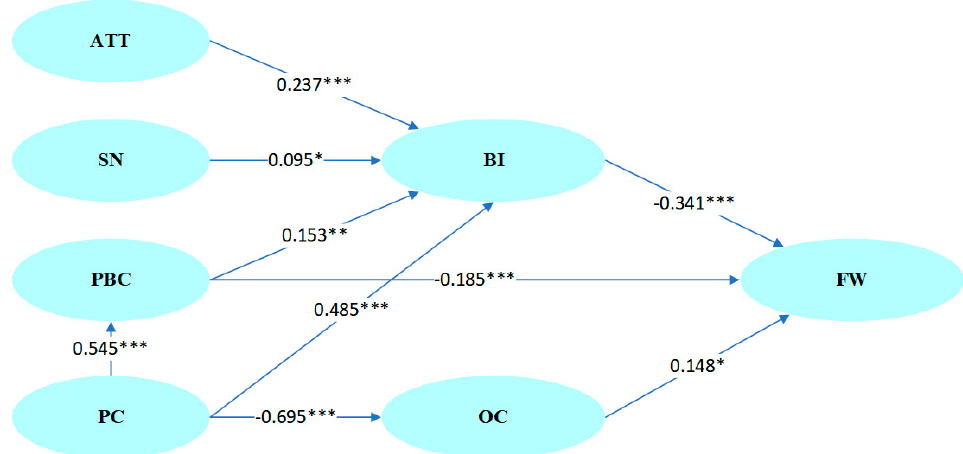
Figure 4. Results of the hypothesized relationships in the SEM model.( * p < 0.05; ** p < 0.01; *** p <0.001.)